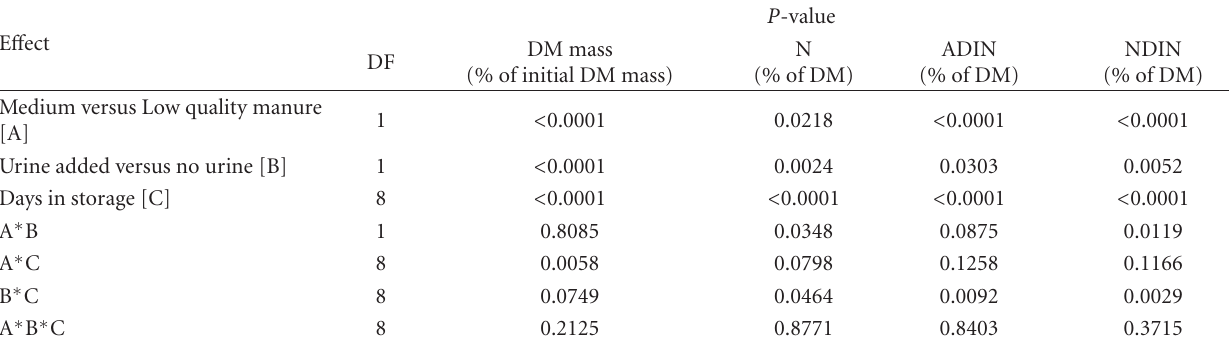
Table 1: ANOVA results for dry matter (DM) mass remaining in manure in storage in the dry season experiment, as a percent of the initial manure DM mass and for N content (DM basis) of manure in storage in the dry season experiment, as a percent of the initial manure N content. Fixed e ff ects are the manure quality (Medium versus Low quality), the presence or absence of urine in the manure, and the number of days the manure was incubated (0, 6, 12, 18, 24, 30, 50, 70, 90, or 120 days). Terms for the interaction between fixed e ff ects are denoted by fixed e ff ects terms separated by an asterisk ( ∗ ). DF represents the degrees of freedom of the test.